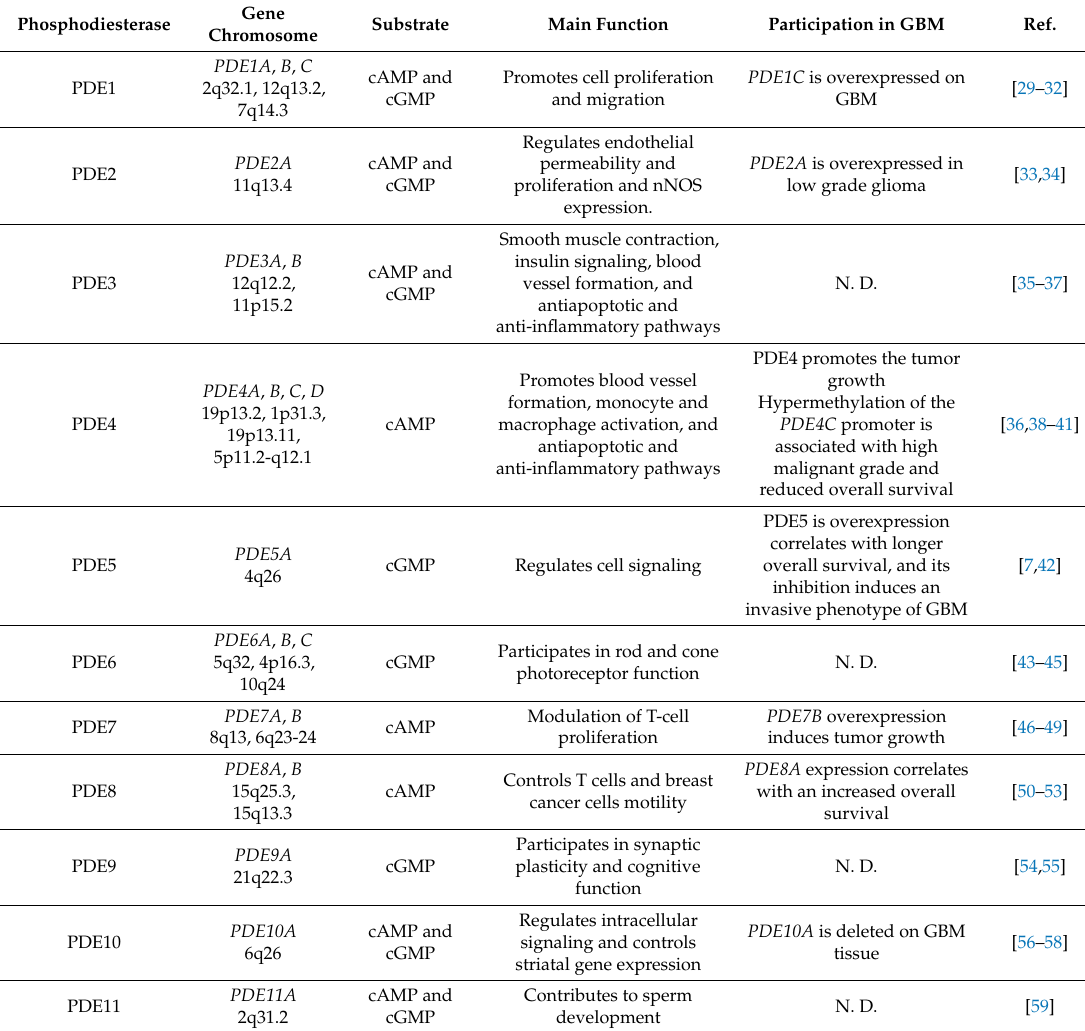
Table 2. Role of phosphodiesterases on